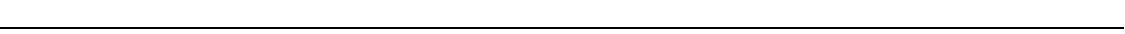
Fig. 4 VEGFR2 and VE-cadherin expression control VEGF-induced EC elongation and migration. Con fl uent HUVECs were treated with 50 ng ml − 1 VEGF or PBS. a Time-lapse images show cell elongation (arrows) in a subpopulation of HUVECs (Scale bar: 30 µ m). b PhaCoB Cell Tracker analysis of cell elongation 5 h after VEGF ( n = 3070 cells, one-way ANOVA). c VEGF-dependent cell velocity in the fi rst 6 h ( n = 71 cells) and after 24 h ( n = 77 cells). d Elongated cells displayed increased 'Euclidean distance' (ED) and 'Accumulated distance' (AD) comparison to polygonal cells in the same VEGF-treated culture ( n = 30 cells from t = 24 – 30 h, two-way ANOVA). e Anti-VE-cadherin-labelled HUVEC cultures. Rel-VEcad-C was decreased in a subpopulation